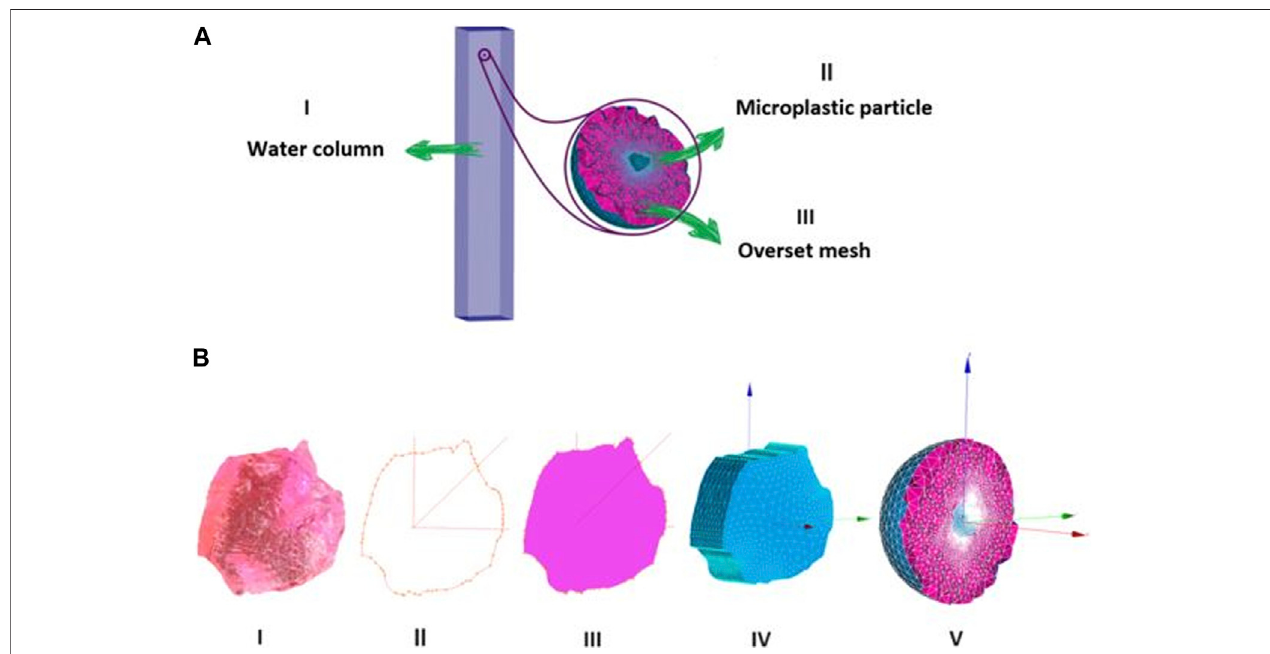
FIGURE1|(A) Schematicoftheusedsetupinallthesimulations:I)Backgroundmesh(watercolumn-18 cm*18 cm*110 cm),II)bodyofadesignedMPparticle,III) Overset mesh around a MP particle, and (B) the steps in generating the particleand overset meshes: I) Image of a realMP particle II) Extracting boundary coordinates of theMPparticleinaCartesiancoordinatesystem.III)BuildingsurfaceplaneoftheMPparticleIV)ExtrudingthebuiltplaneinthethirddimensionasmuchasitsthicknessV) Overset mesh around the 3D MP particle.